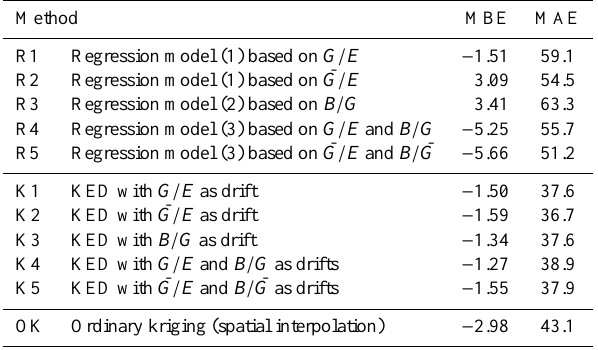
Table 1. Cross validation mean bias error (MBE) and mean ab- solute error (MAE) in minutes per day. G and ¯ G denote the solar radiation data from the CM SAF data and the composite dataset,